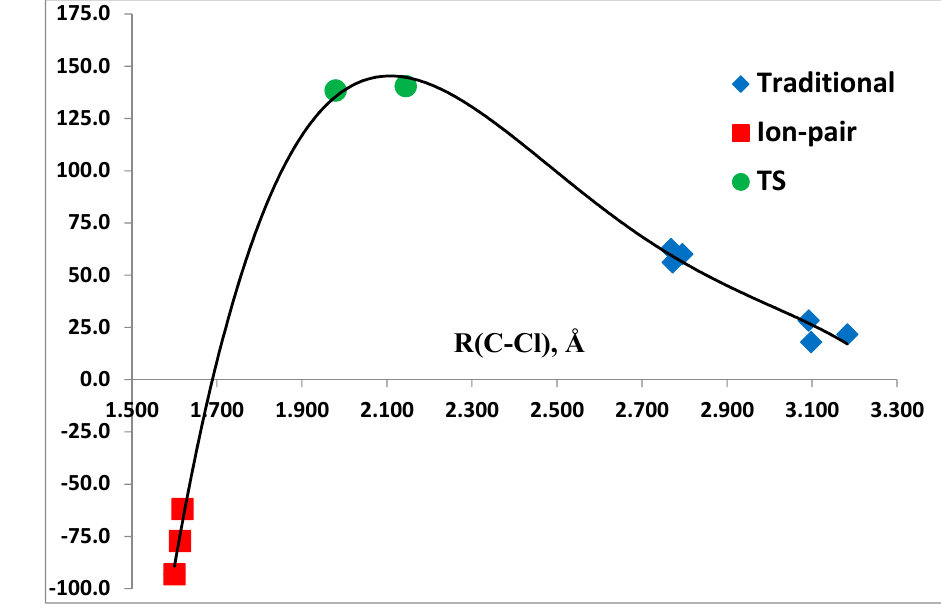
Figure 7. 1x J(C–Cl) for complexes with traditional halogen bonds and transition structures with chlorine-shared halogen bonds, and 1 J(C–Cl) for ion-pair complexes versus the C–Cl distance. Coupling constants 1x J(Cl–F), 1x J(Cl–Cl), 1x J(Cl–N) across the new Cl ... A halogen bonds and